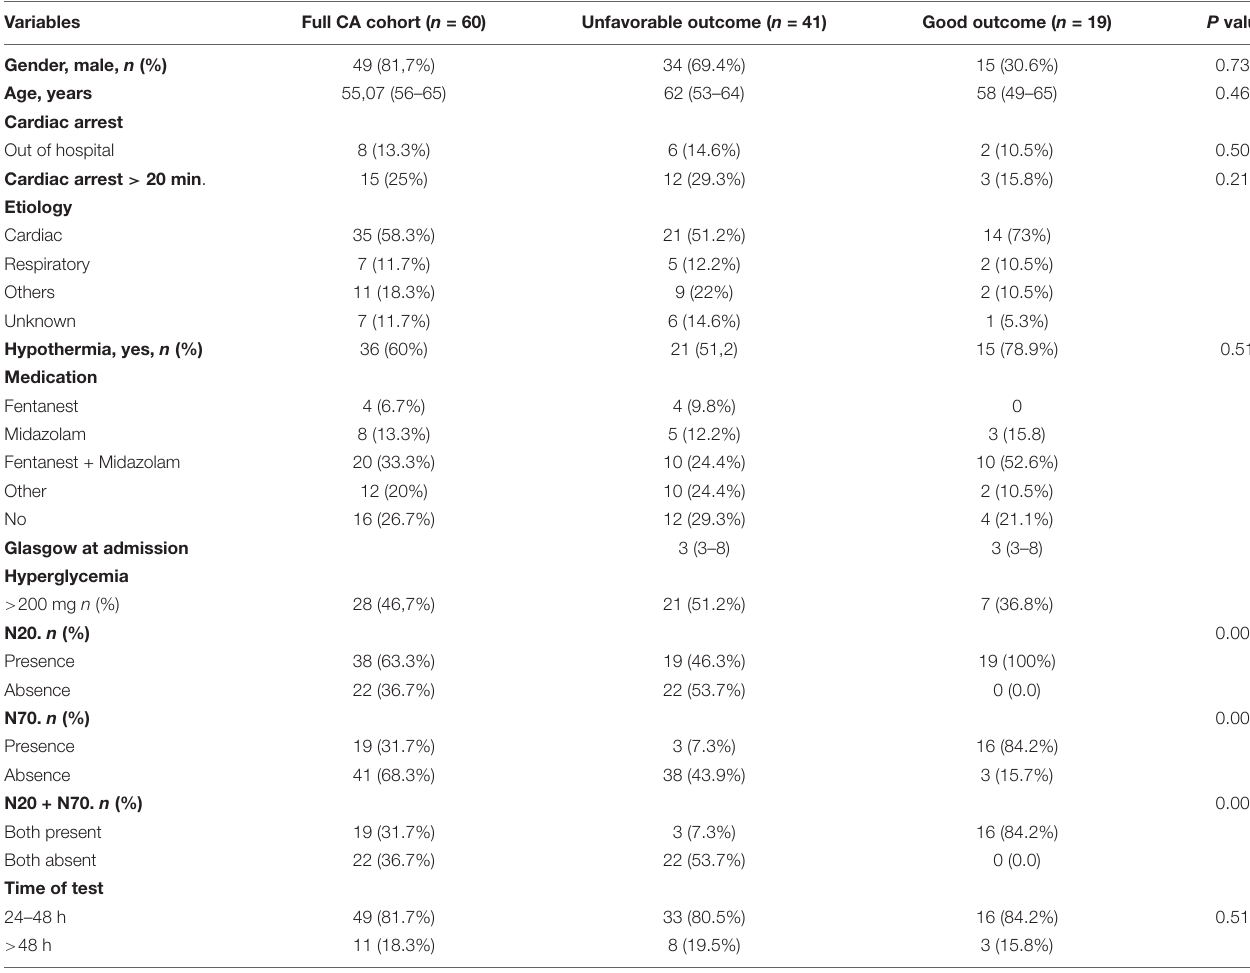
TABLE 1 | Characteristics of the study population in cardiac arrest (CA) ( n =